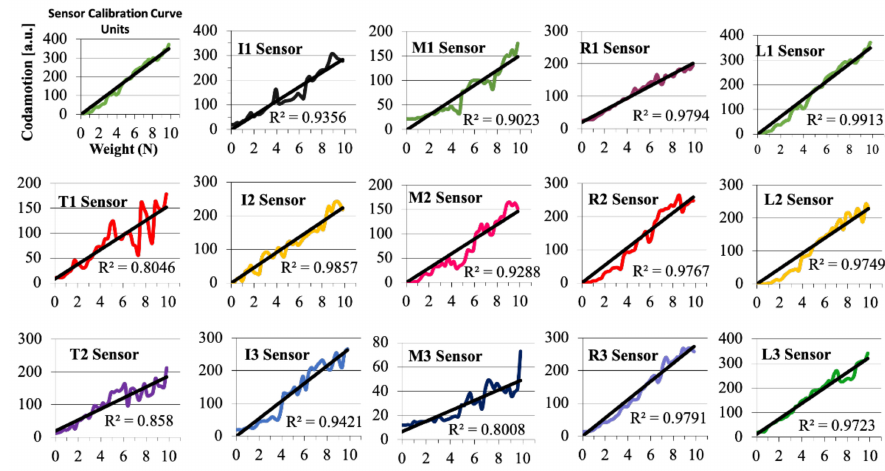
Figure 4. Calibration curve of each sensor embedded in the force glove.